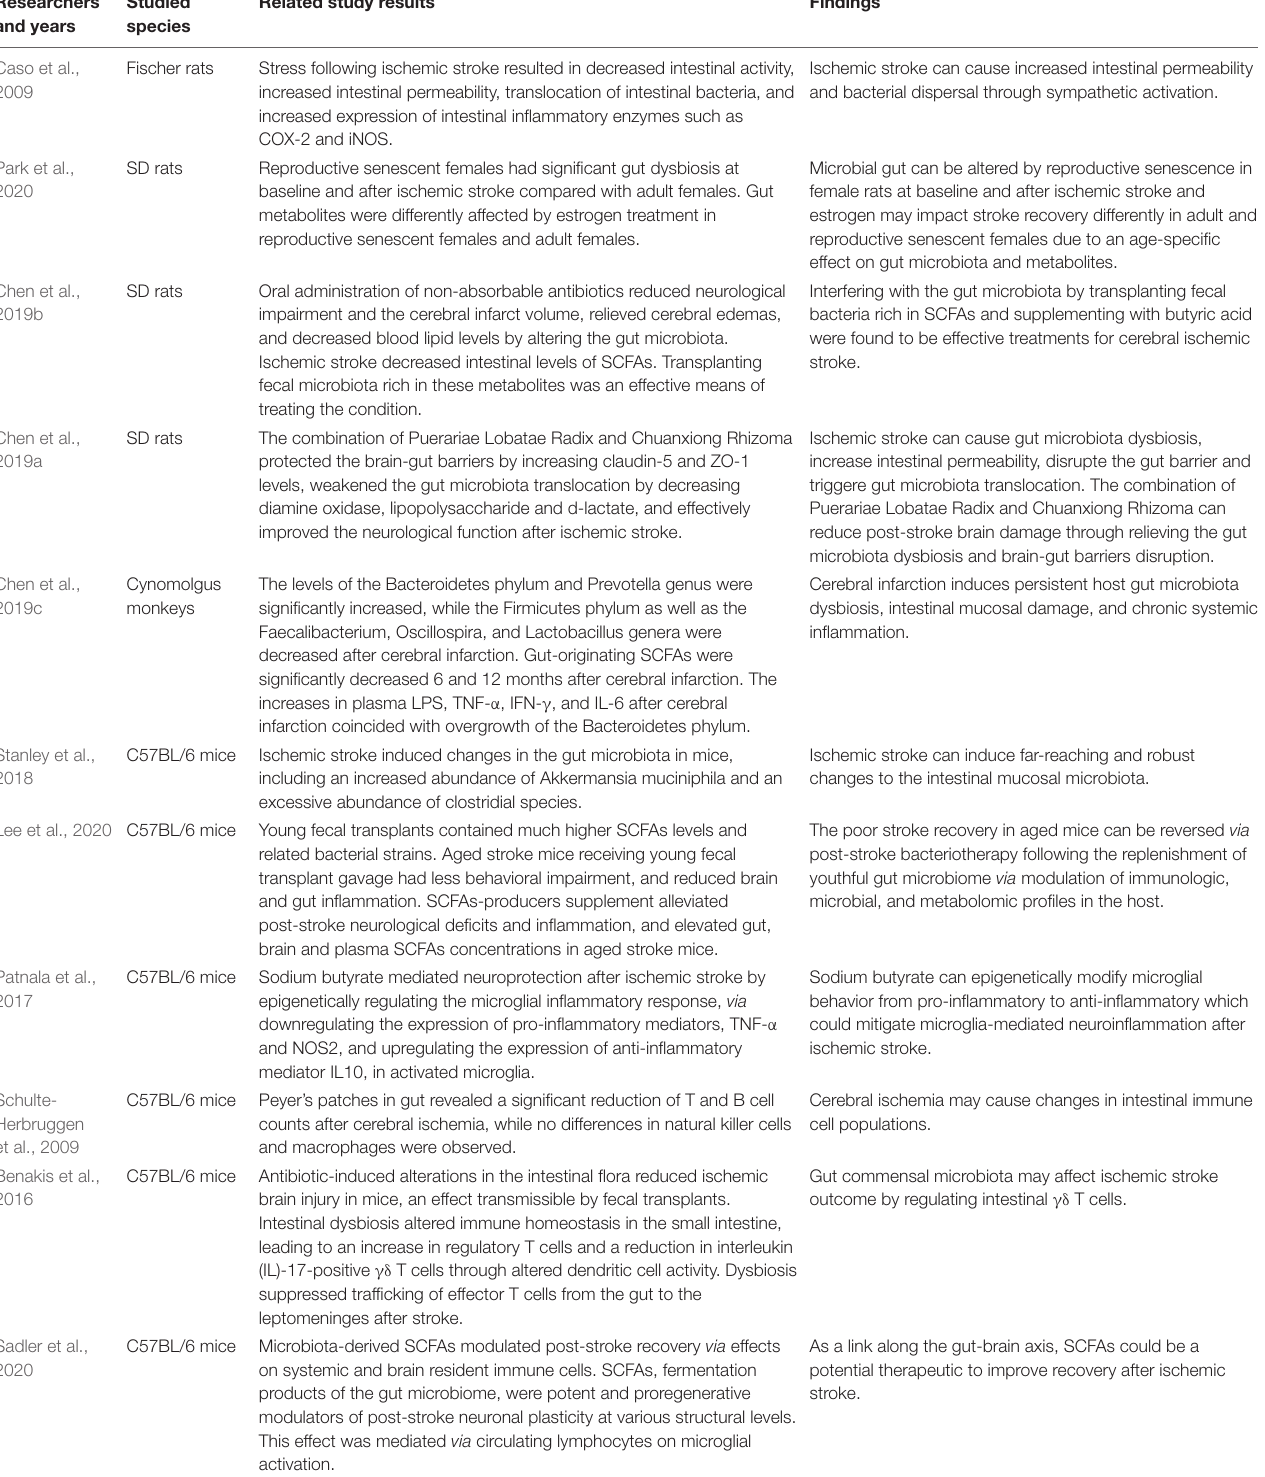
TABLE 1 | Related studies exploring the relationship between gut microbiota and ischemic